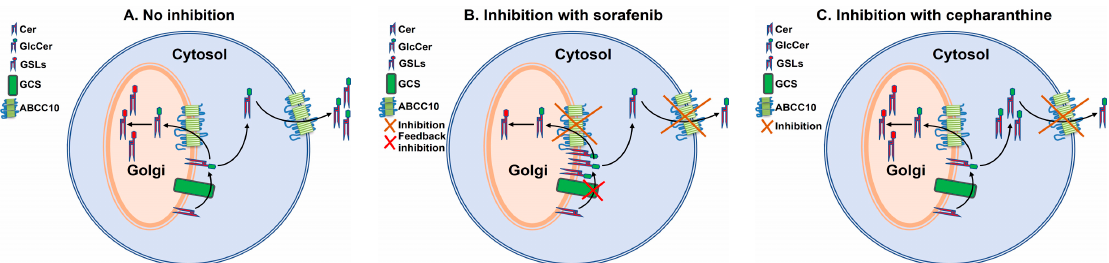
Figure 8. Proposed schematic representation of GlcCer transport by ABCC10 under different cellular stimuli. Under normal conditions, ( A ) glucosylceramide synthase (GCS) present on the cytosolic side of the Golgi converts ceramide (Cer) to glucosylceramide (GlcCer), which may be either translocated to the lumen by Golgi membrane-bound ABCC10 for further glycosylation to form complex glycosphingolipids (GSLs) or effluxed to the media by cell membrane-bound ABCC10. Inhibition of Golgi membrane- and cell membrane-bound ABCC10 with sorafenib ( B ) blocks translocation of GlcCer to the lumen or media and, therefore, may result in the feedback inhibition of GCS, leading to less synthesis of GlcCer. Inhibition of cell membrane-bound ABCC10 with cepharanthine ( C ) may prevent only the efflux of GlcCer to the media and, thereby, results in increased accumulation of GlcCer in the cells.